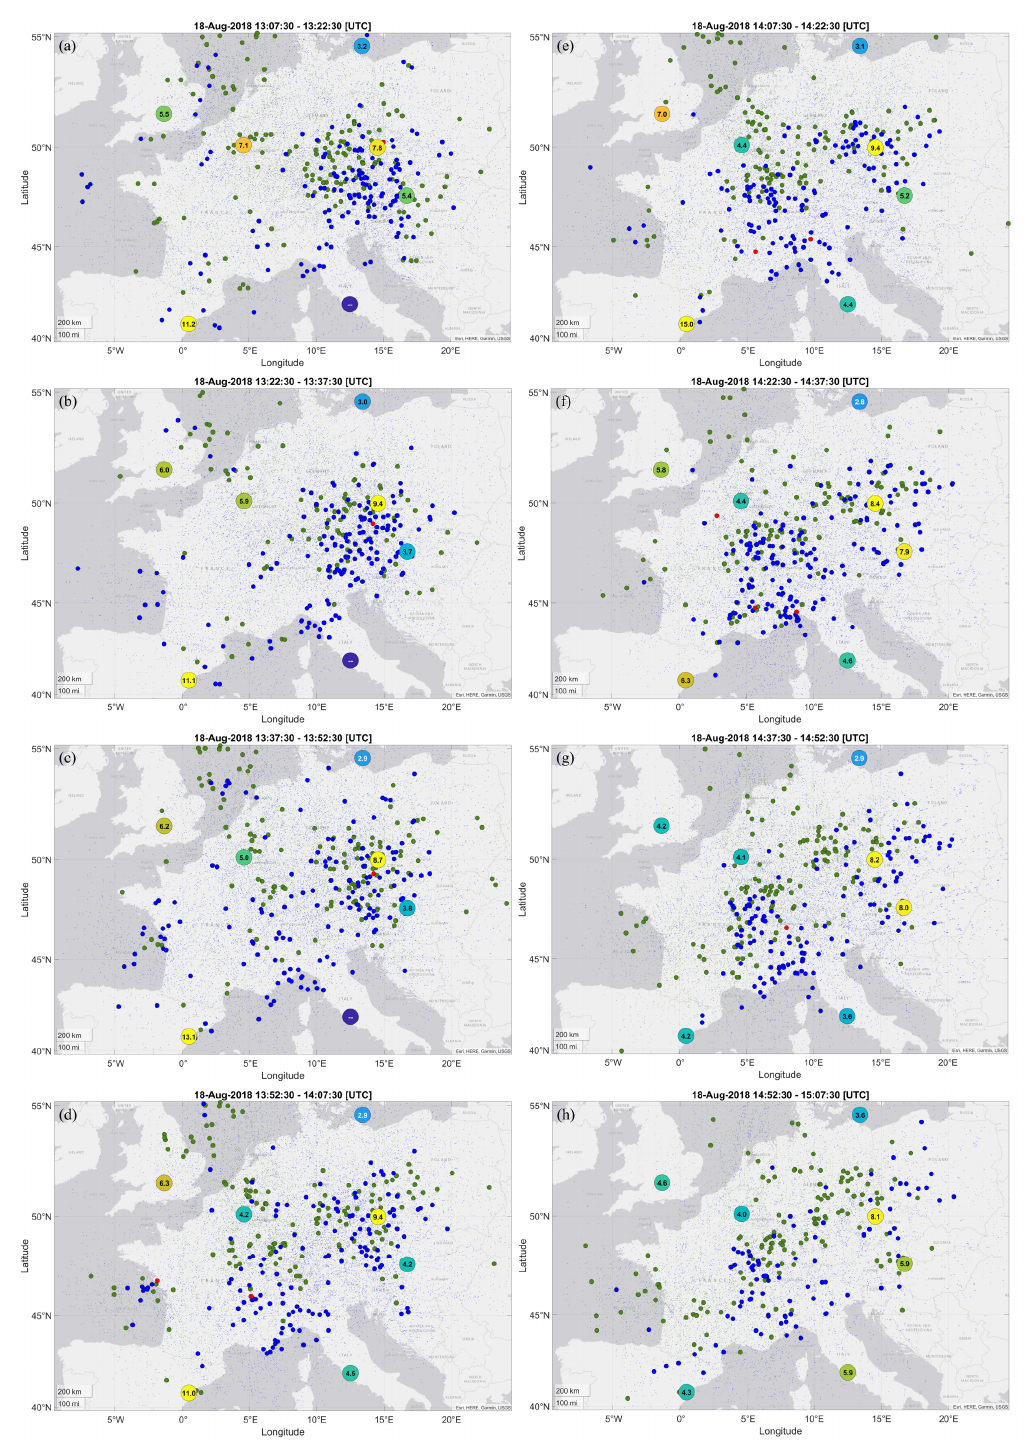
Figure 8. ( a – h ). First part of sporadic E event 18 August 2018, sequential 15 min samples centered from 13:15 UTC to 15:00 UTC. Large circles: ionosonde-derived f t Es [MHz] (dark = low, pale = high, – = no Es). Medium circles: approximate signal reflection points (green = 28 MHz, blue = 50 MHz, red = 70 MHz). Dots: estimated coverage (colors ditto).